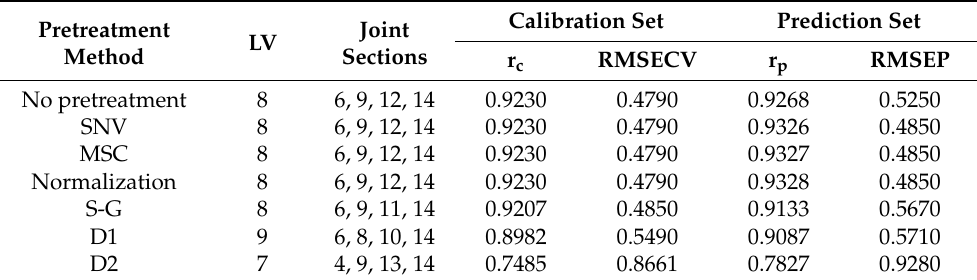
Table 2. Optimum condition for establishing NIRS models of gellan gum content in the liquid fermentation process after different mathematical pretreatments.